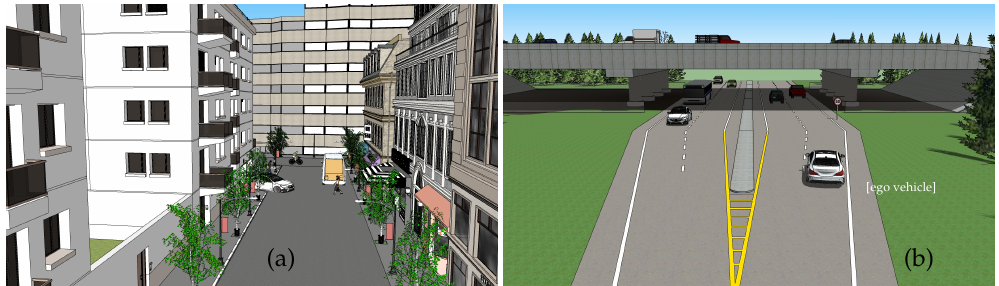
Figure 4. Collada-type models for the road scenes (intra-urban ( a ) and extra-urban ( b